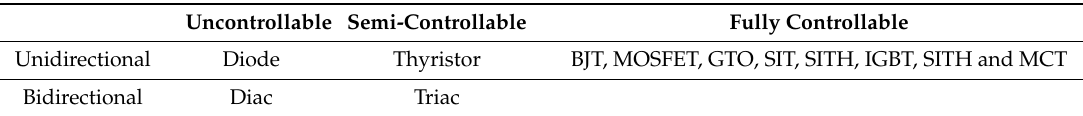
Comparison of the Power Electronic Switches across their Controllability and Bidirectional Capability.